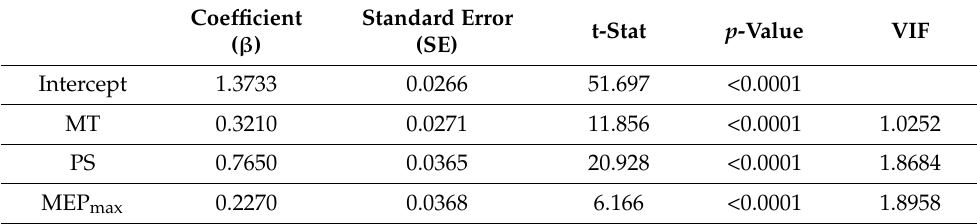
Table 1. General Linear Model (GLM) of MEP amp with MT, PS and MEP max as predictor variables.